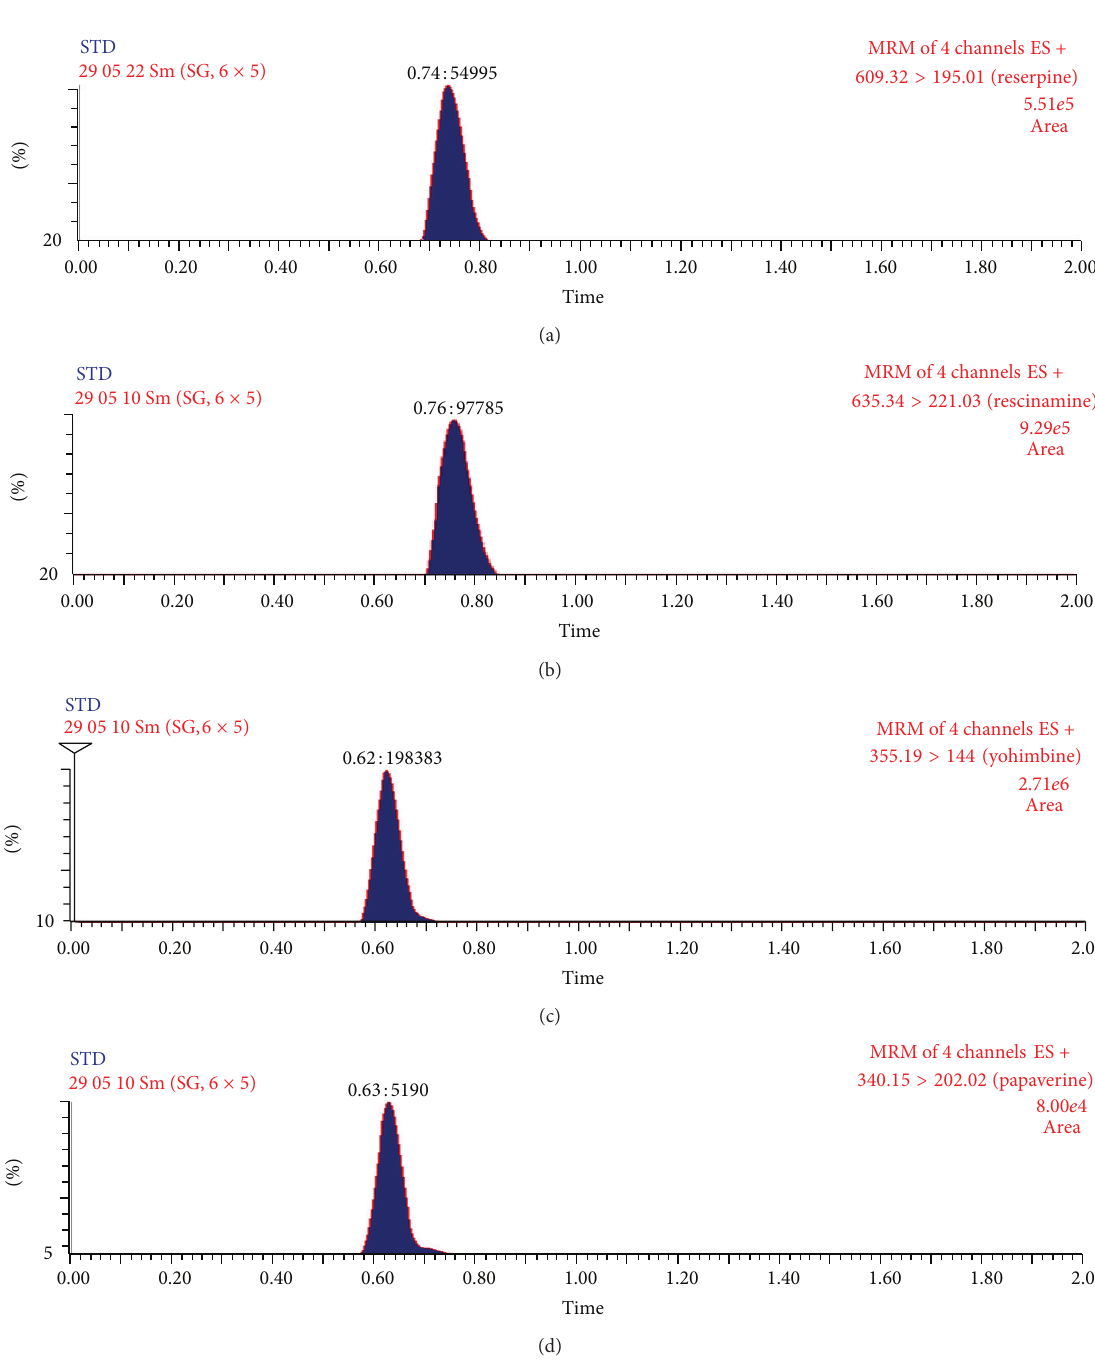
respectively. The mean recovery for the papaverine (IS) at the concentration employed was 76.9%. This result indicates that the extraction efficiency for reserpine, rescinnamine, and yohimbine using protein precipitation method was satisfactory, consistent, and concentration independent. The ionization suppression or enhancement effects were between ± 15%, indicating no relative matrix